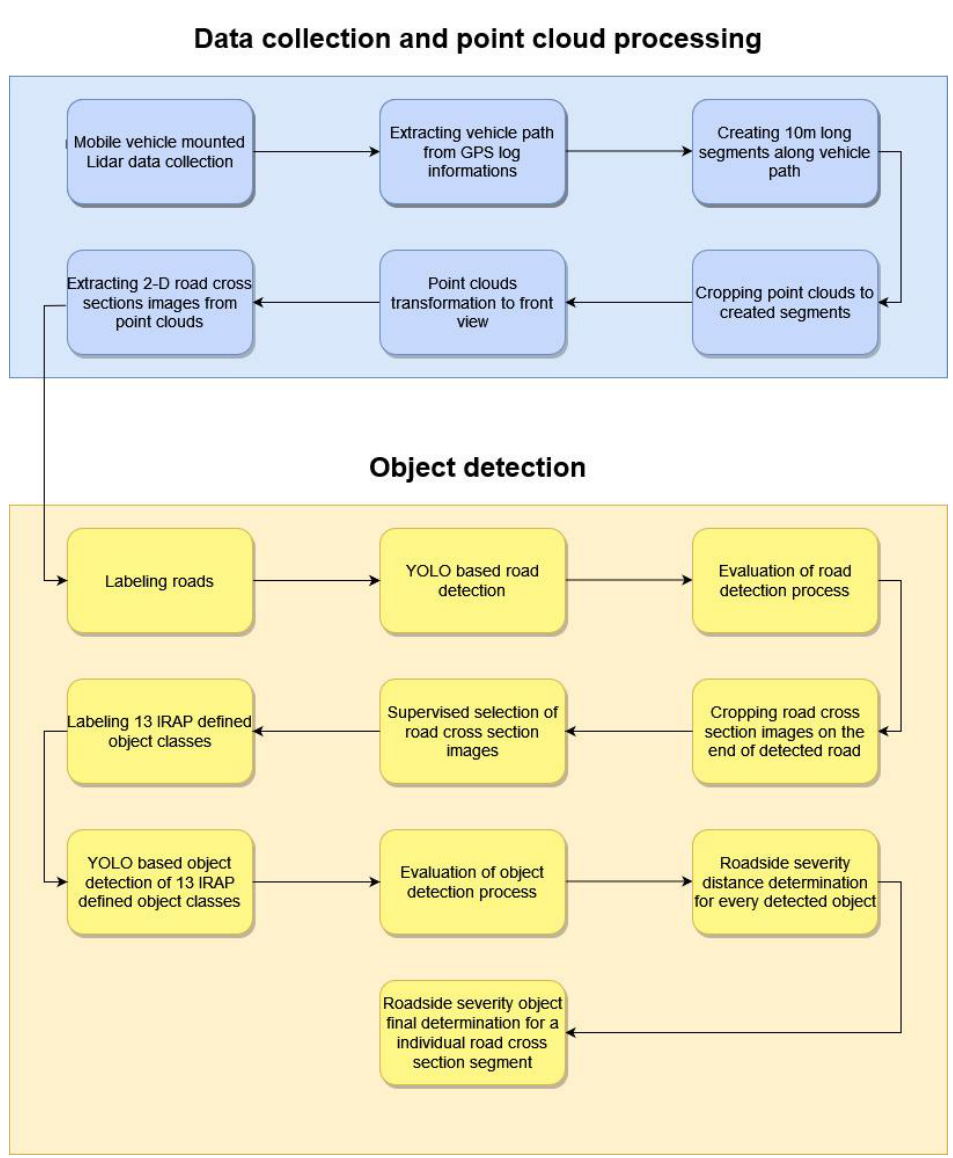
Figure 1. Proposed framework for the determination of RSS – O and RSS – D attribute.